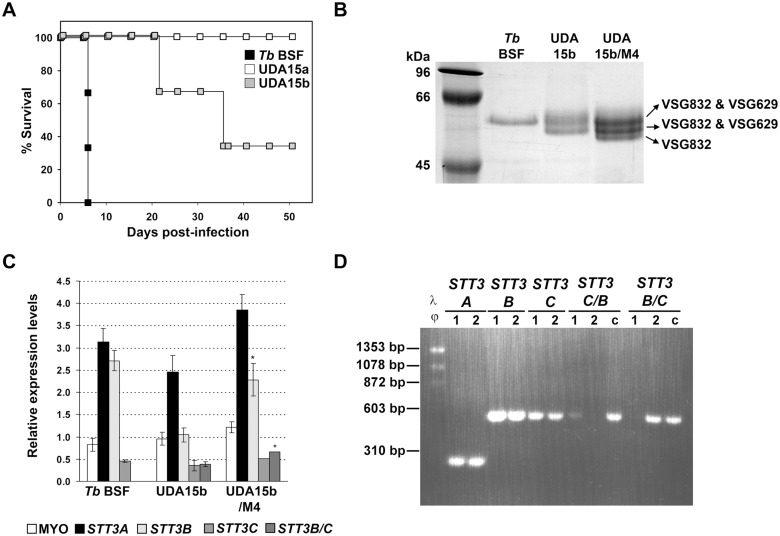
Survival of mice inoculated with UDA-resistant parasites.A) Kaplan-Meier survival analysis of mice infected with parental (Tb BSF), and UDA15a and UDA15b resistant parasites. B) SDS/PAGE analysis of sVSG expressed in UDA15b parasites isolated from mouse #4 (UDA15b/M4) at the final point of infection. Coomassie blue stained bands were identified by MALDI-TOF analysis. C) Relative expression of TbSTT3 genes in UDA15b/M4 was determined by RT-qPCR. The asterisks indicate significant differences according to the Student’s t-test (n = 3). *, p < 0.005 vs the UDA15b strain. D) PCR analysis of full-length and chimeric TbSTT3 genes in genomic DNA from (1) Tb BSF, (2) UDA15b/M4 and (c) HHA20 as control [19].